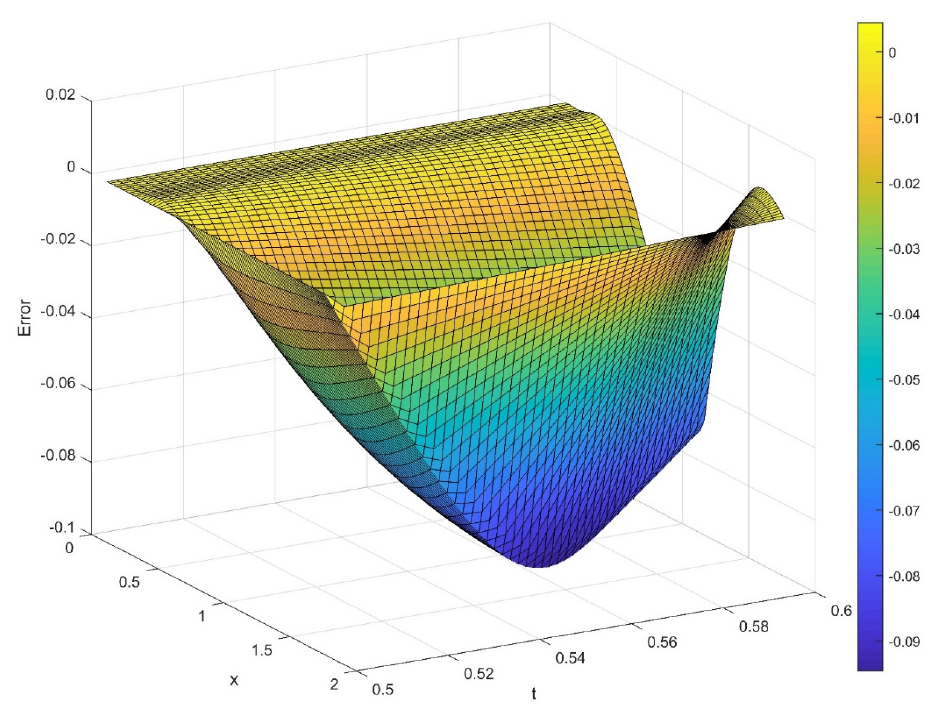
Figure 13. The difference between the analytical solution and the LH method for h = 2.1 · 10 − 3 as a function of space and time for Experiment 4.